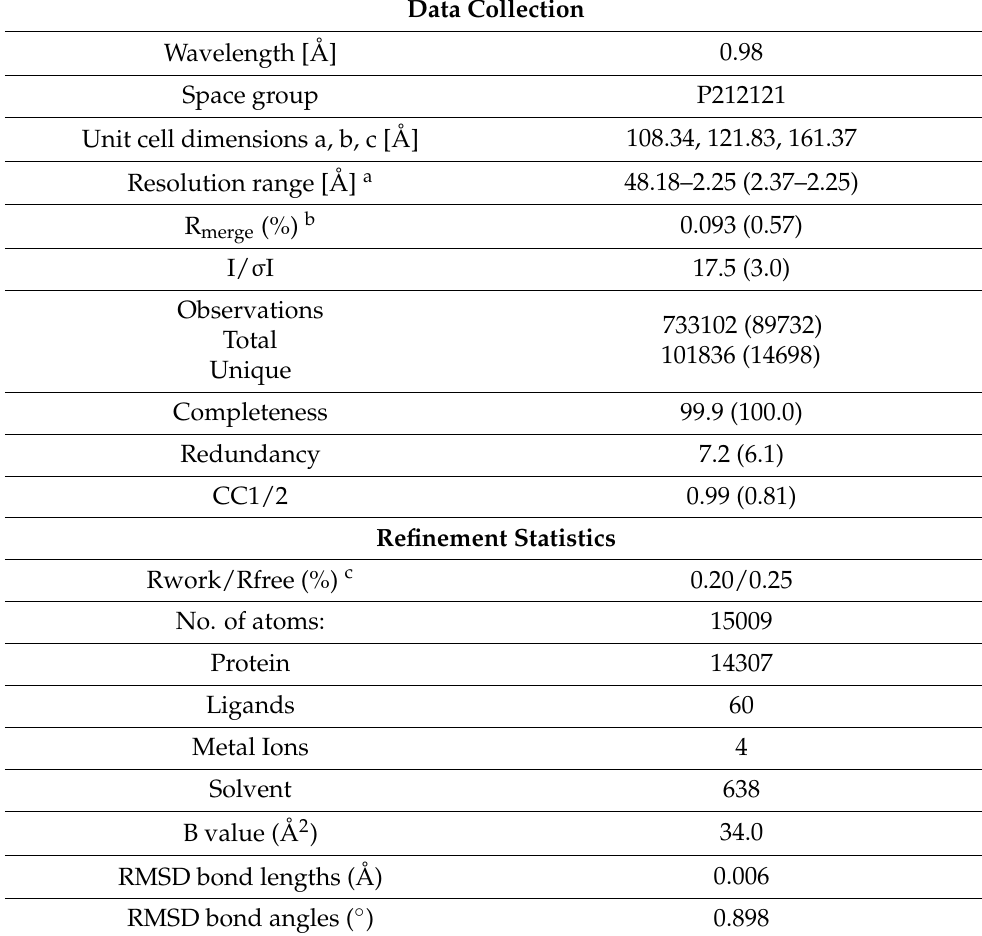
Table 4. Data collection and refinement